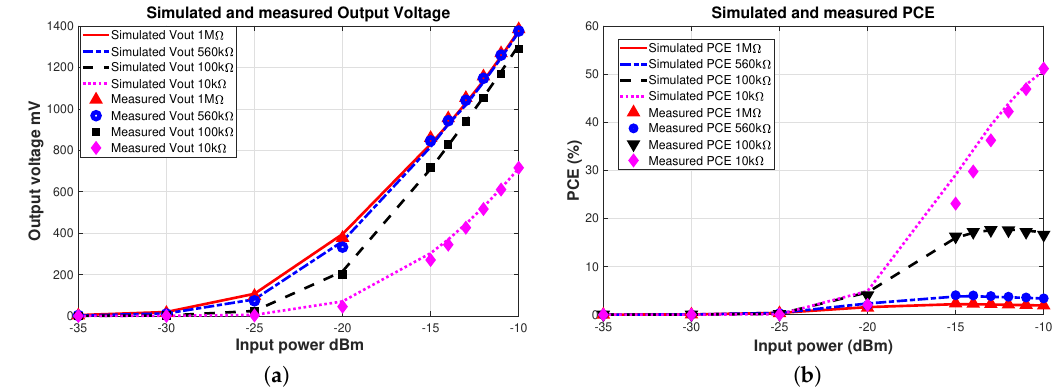
Figure 14. Measured and simulated output of the RFEH system with the signal generator when the system is excited by continuous sine wave (CW) signal: ( a ) Output voltages and ( b ) power conversion efficiency (PCE) at different loads and input power.